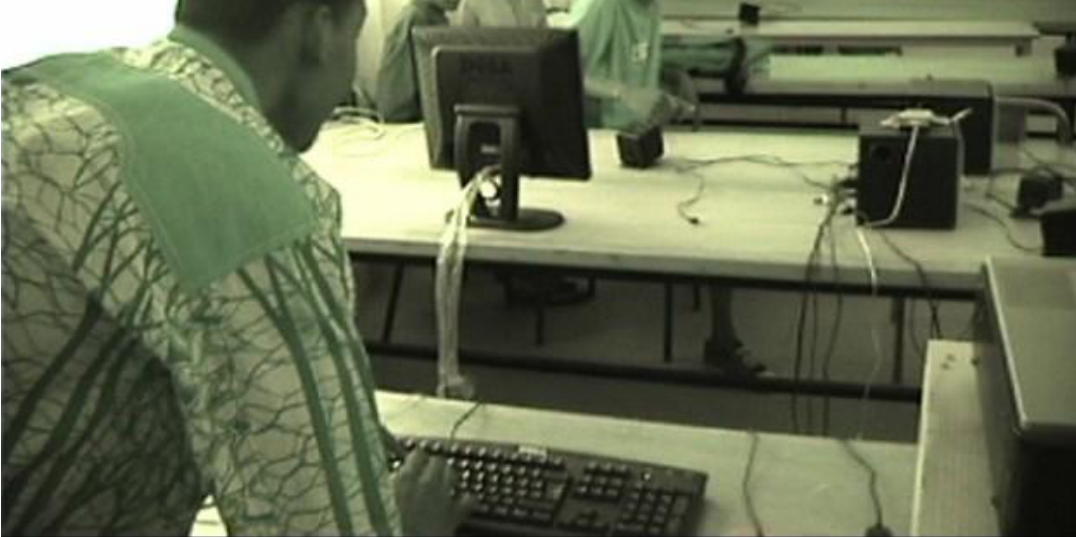
Figure 1 . A partial view of the DE classroom setting at the AVU-Ouagadougou in Burkina Faso, where a student is typing an answer.